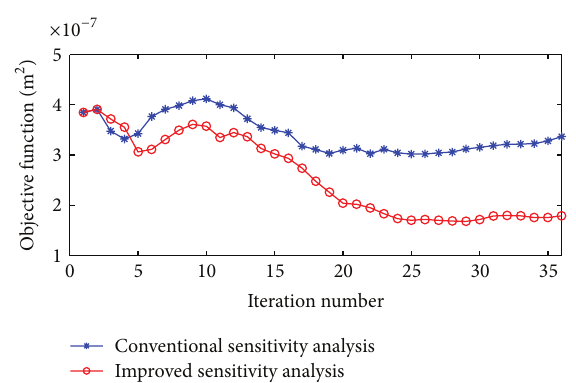
Figure 14: Iteration histories of the modal damp